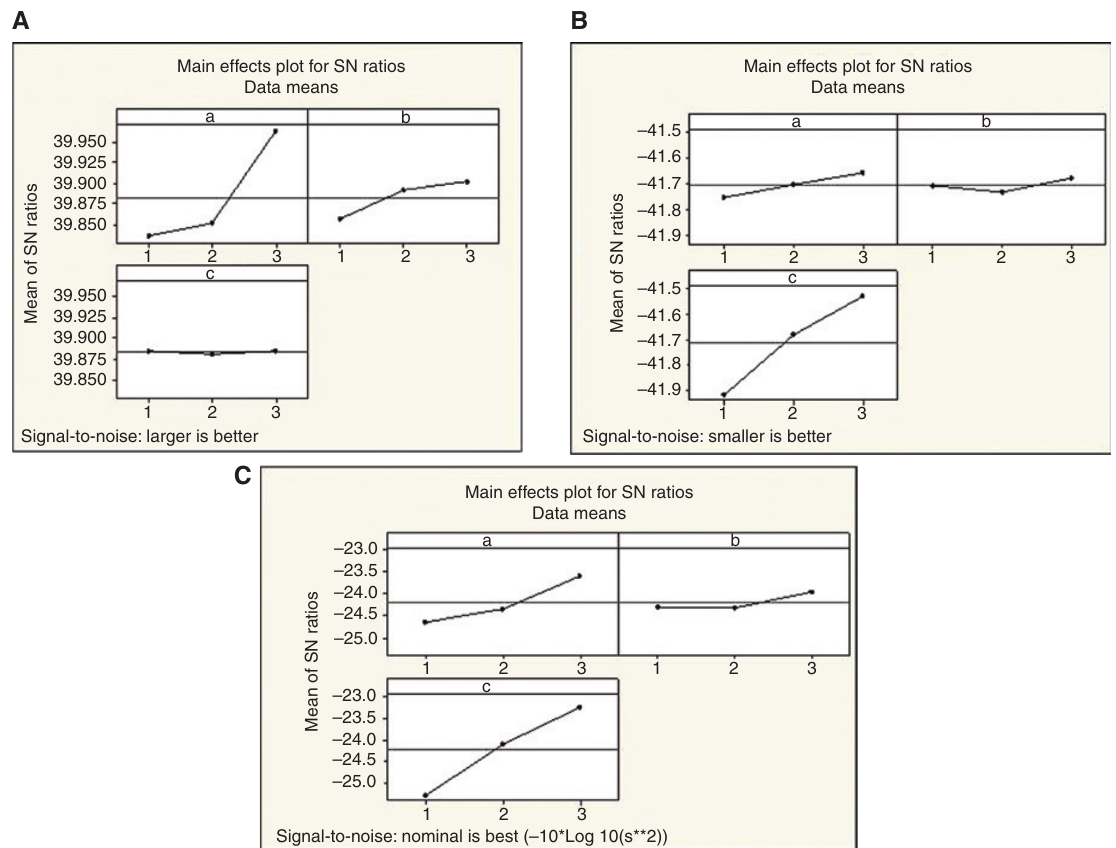
Figure 1: Taguchi analysis of significant factors individually: (A) main effect plots on entrapment efficiency (Y1); (B) particle size (Y2); (C) combined effects on Y1 and